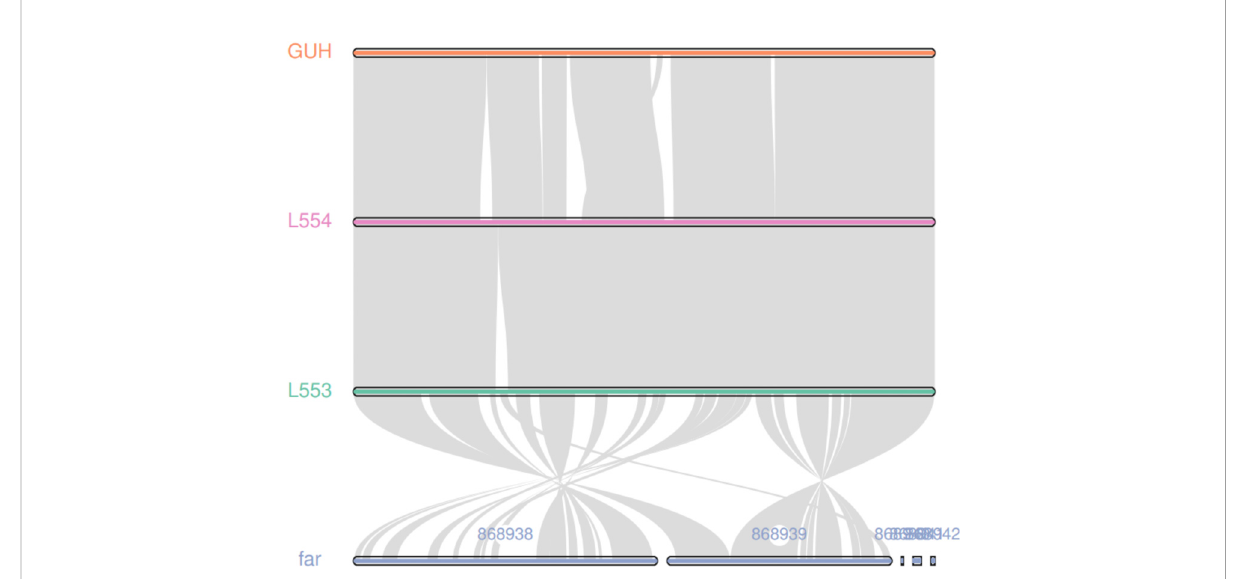
FIGURE 4 Colinear analysis of the coding gene sequence of strains L5.53 and L5.54. The coding genes of isolates L5.53 and L5.54 were highly consistent with N. cyriacigeorgica GUH-2, and isolate L5.53 and N. farcinica had many same collinear gene sequences. But there were lots of genomic rearrangements such as deletion, inversion and translocation between